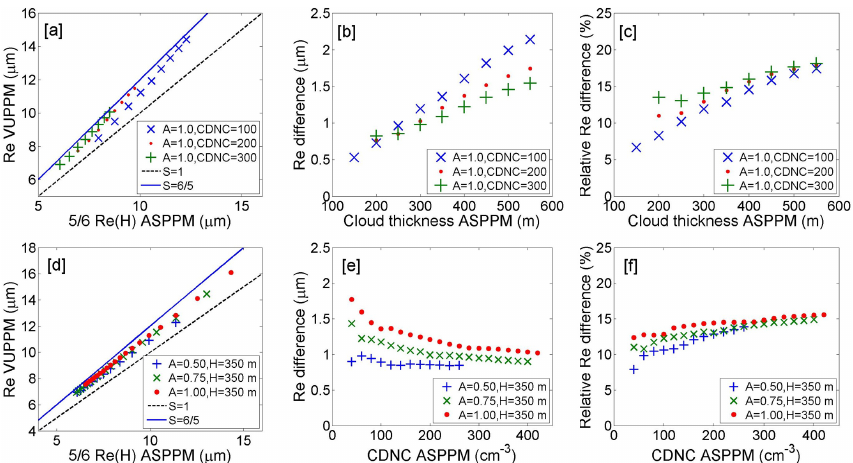
Fig. 12. Comparisons of retrieved R e from VUPPM and ASPPM for a given adiabaticity (a) and a given cloud geometric thickness (d) ; The R e difference as a function of cloud geometric thickness (b) and cloud drop number concentration (CDNC) (e) ; The relative R e difference as a function of cloud geometric thickness (c) and CDNC (f) . 2